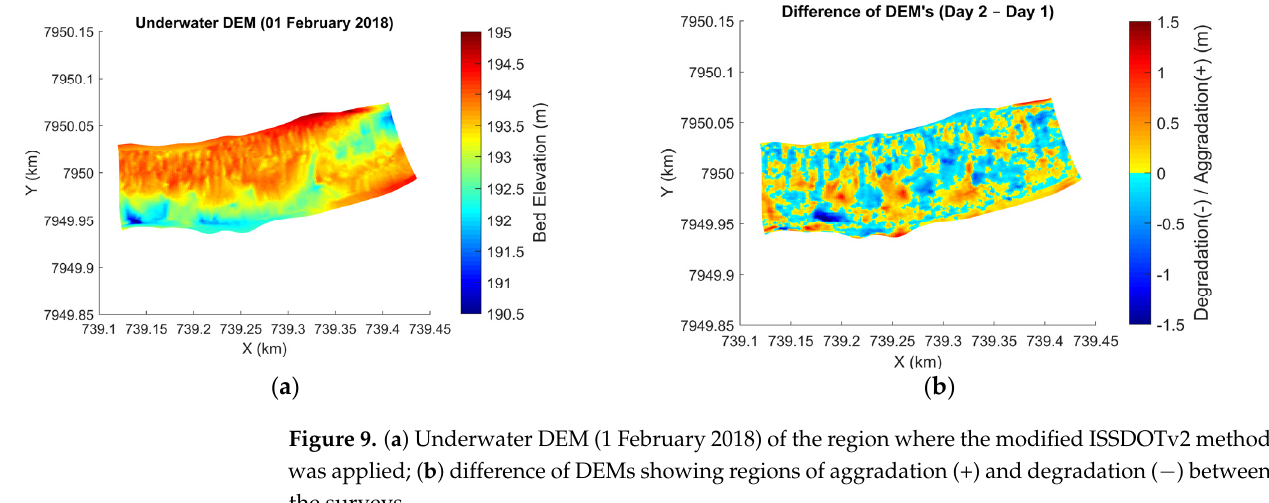
Figure 10. Moving-bed velocities measured with ADCP on 31 January 2018 at the six verticals of cross-section P1, in Taquari River.